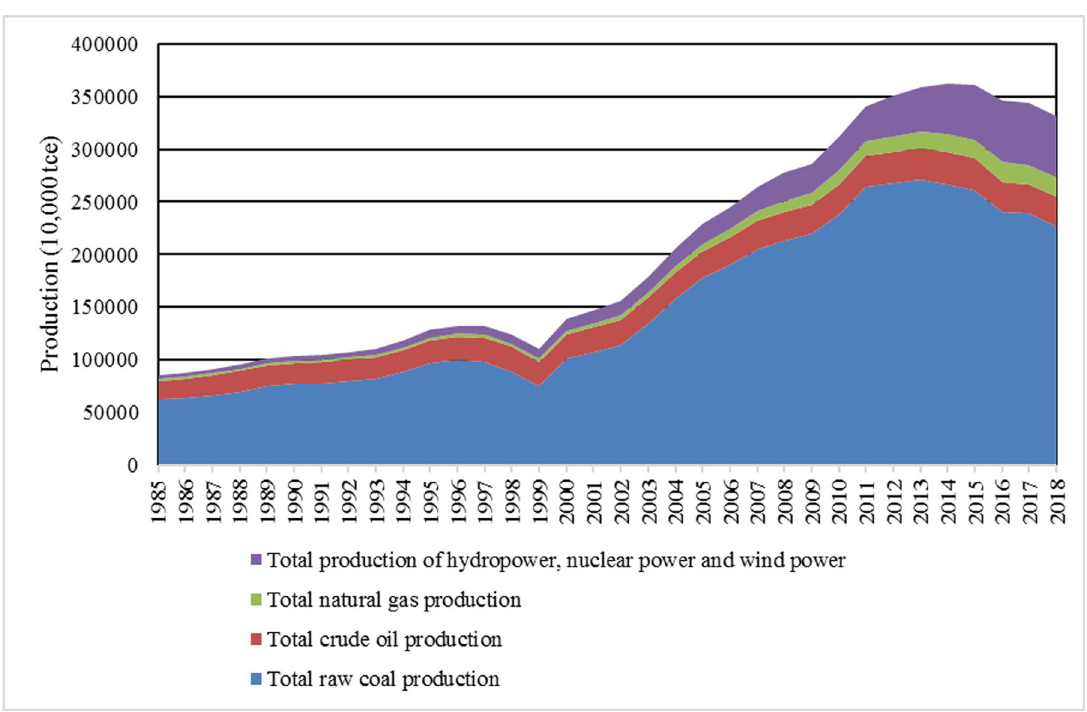
Fig 3. China’s total energy production and its composition from 1985 to 2018. Data source: China Statistical Yearbook. https://data. stats.gov.cn/index.htm.